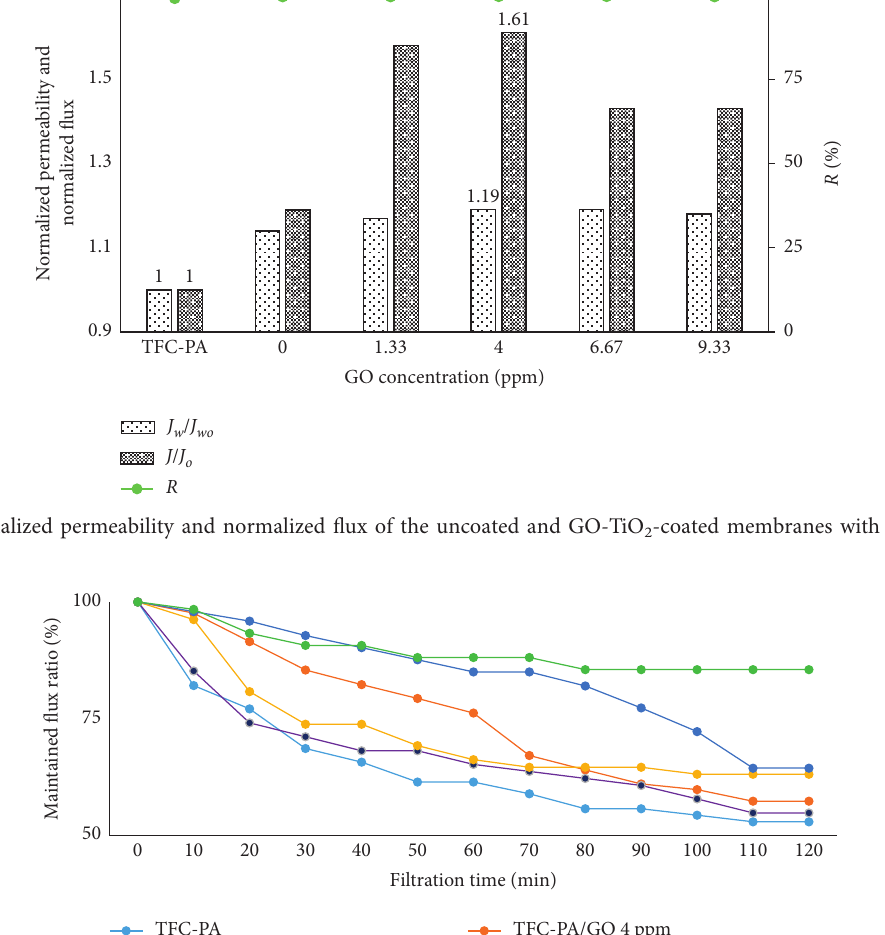
Figure 8: Maintained flux ratios of the uncoated and coated membranes.